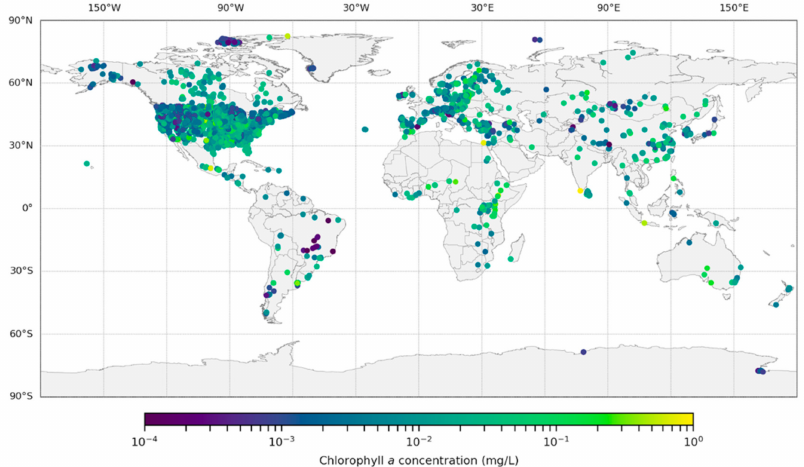
Figure 2. Global distribution of 9313 lakes with measured in situ chlorophyll concentrations. Chlorophyll a concentrations are illustrated by color on a logarithmic scale. Lakes are located in 72 countries across all